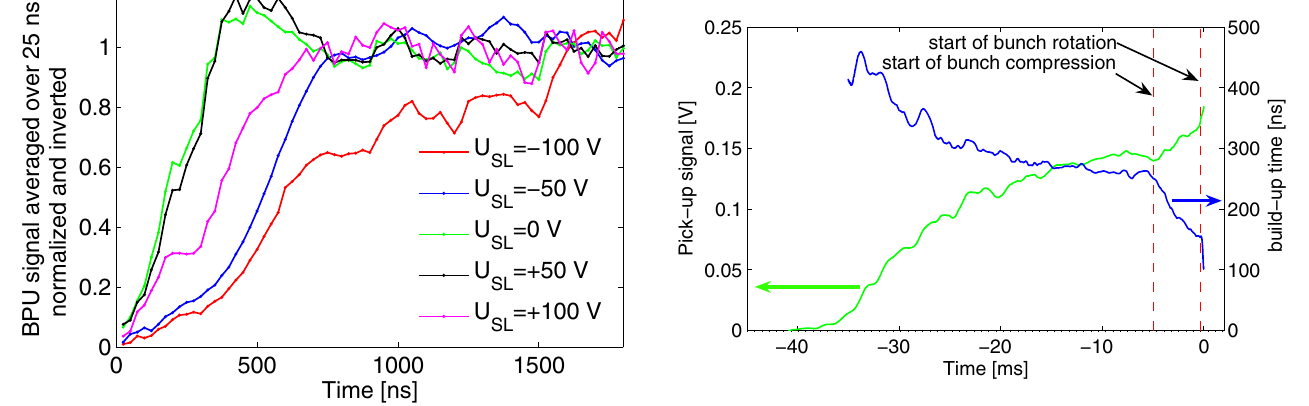
FIG. 10. (Color) Electron cloud buildup time for small clearing voltages without magnetic field. The raw signal from the pickup #2 was averaged for each bunch, normalized to the maximum signal value in the bunch train and inverted. Without magnetic field the curves closely follow